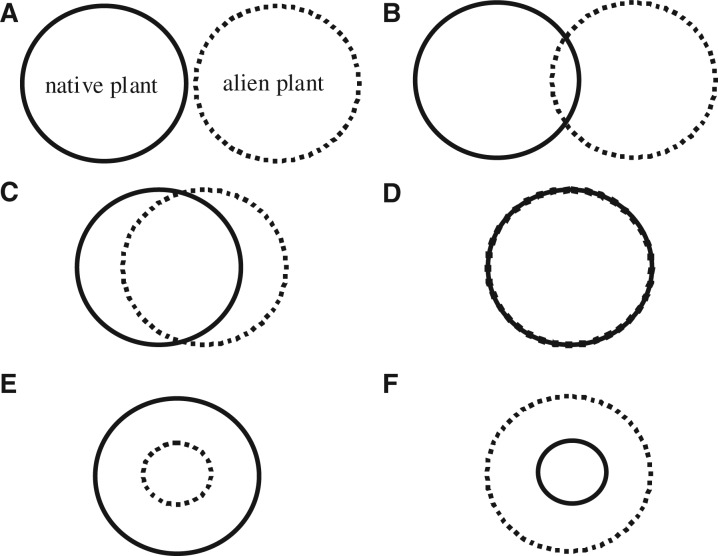
Example of the distribution of an alien plant (dashed line) relative to the distribution of a native plant (solid line), in which (A) there is no overlap in their distributions; (B) there is partial overlap on the margins of their respective distributional limits; (C) major overlap including core distributions of each species; (D) there is complete overlap; (E) the distribution of the alien is a subset of the native's distribution; and (F) the distribution of the native is a subset of the alien's.